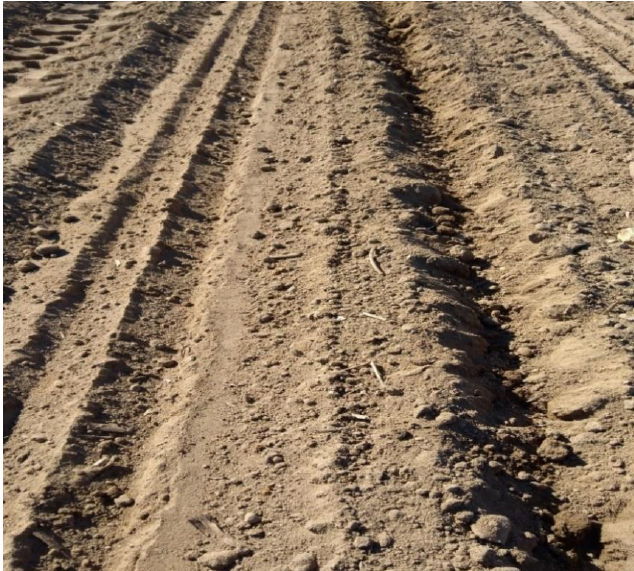
Figure 4. View of the field after placement. A trace of a seed coulter is visible on the left, and a fertilizer coulter on the right (20 cm from kernels, depth—15 cm) (photo taken by Szulc P.).